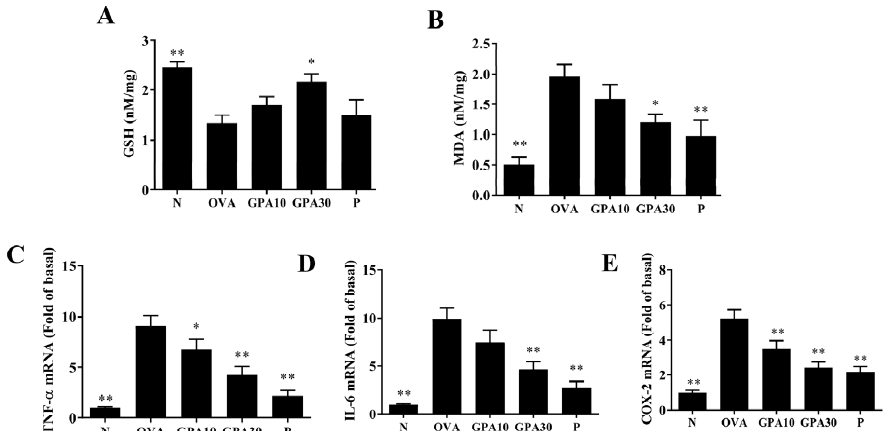
Figure 5. Effects of gypenoside A (GPA) on oxidative stress and inflammation in lung tissue. ( A ) GSH activity, and ( B ) MDA activity for oxidative stress. ( C ) TNF- α , ( D ) IL-6 , and ( E ) COX-2 gene expression promoting inflammation in lung tissue. The data are presented as the mean ± SEM of three independent experiments (n = 8 per group). * p < 0.05, ** p < 0.01 compared with the OVA control group. Normal saline control group were named as N; Ovalbumin (OVA)-induced asthma mice were named as OVA. The 10 mg/kg and 30 mg/kg gypenoside A were named as GPA10 and GPA30, respectively. The 5 mg/kg prednisolone was named as P.